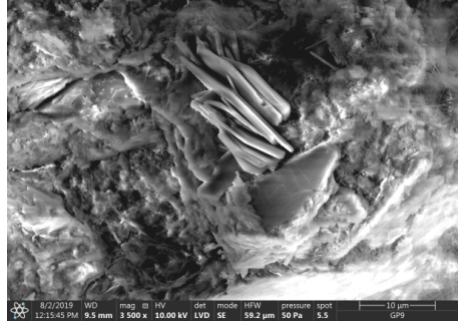
Figure 21. Microstructure of ZV mortar (FBC II) after 90 days of curing in seawater solution.